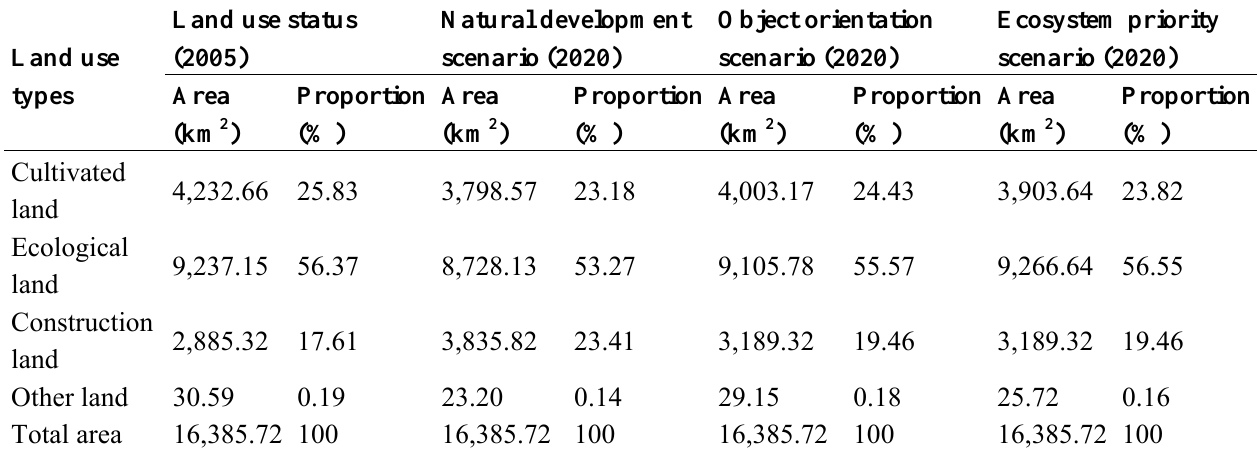
Table 4. The predicted areas of land use in 2020 of Beijing in different